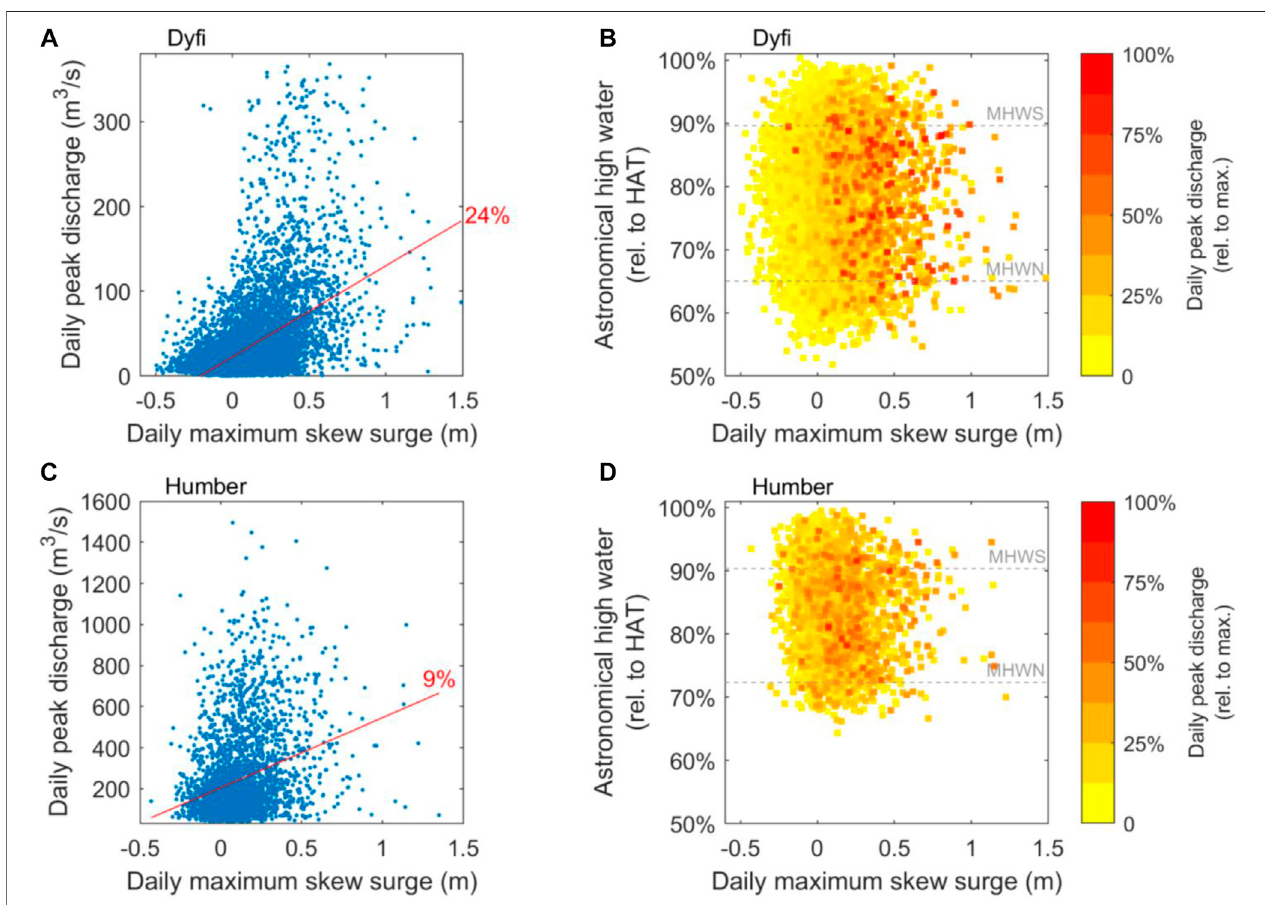
FIGURE 5 | Relationship between daily maximum skew surge and daily peak river discharge, for (A) Dy fi and (C) Humber. The linear regression lines are plotted in red withthe R 2 value (asapercentage).Three-way relationship betweendailymaximumskew surge, dailymaximum astronomicaltideand dailypeak riverdischarge, for (B) Dy fi and (D) Humber. The mean high water spring (MHWS) and mean high water neap (MHWN) levels are